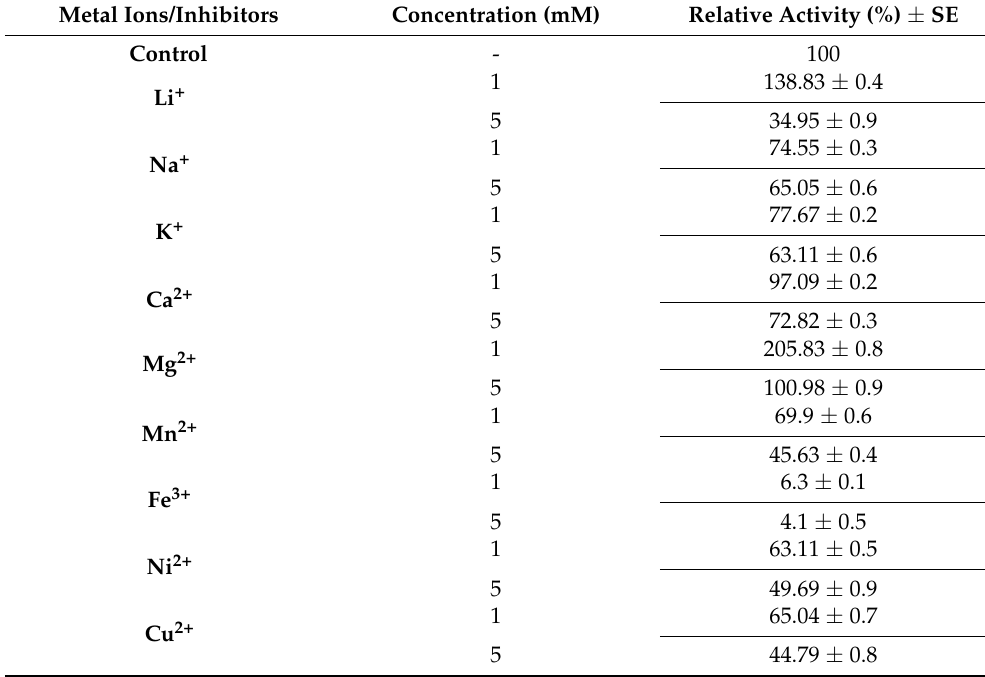
Table 3. Effect of various metal ions on the stability of purified A. geothermalis ALDH. Metal Ions/Inhibitors